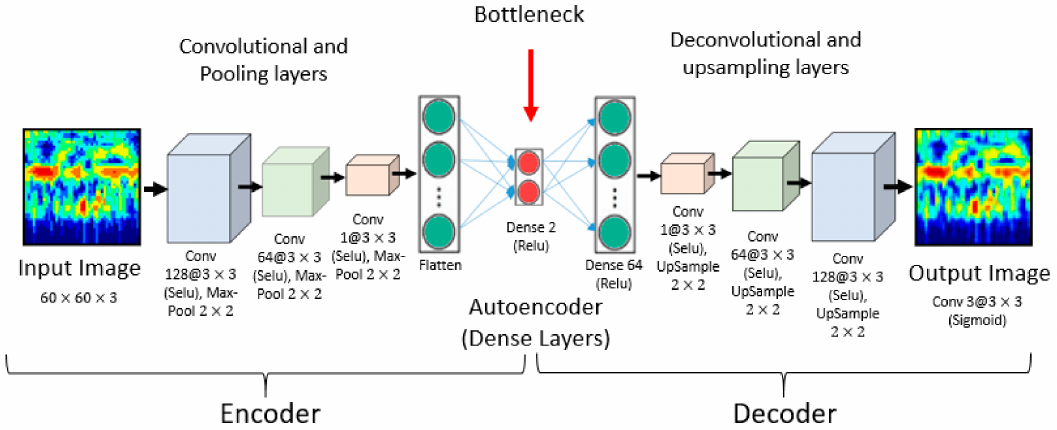
Figure 4. The overall convolutional autoencoder architecture